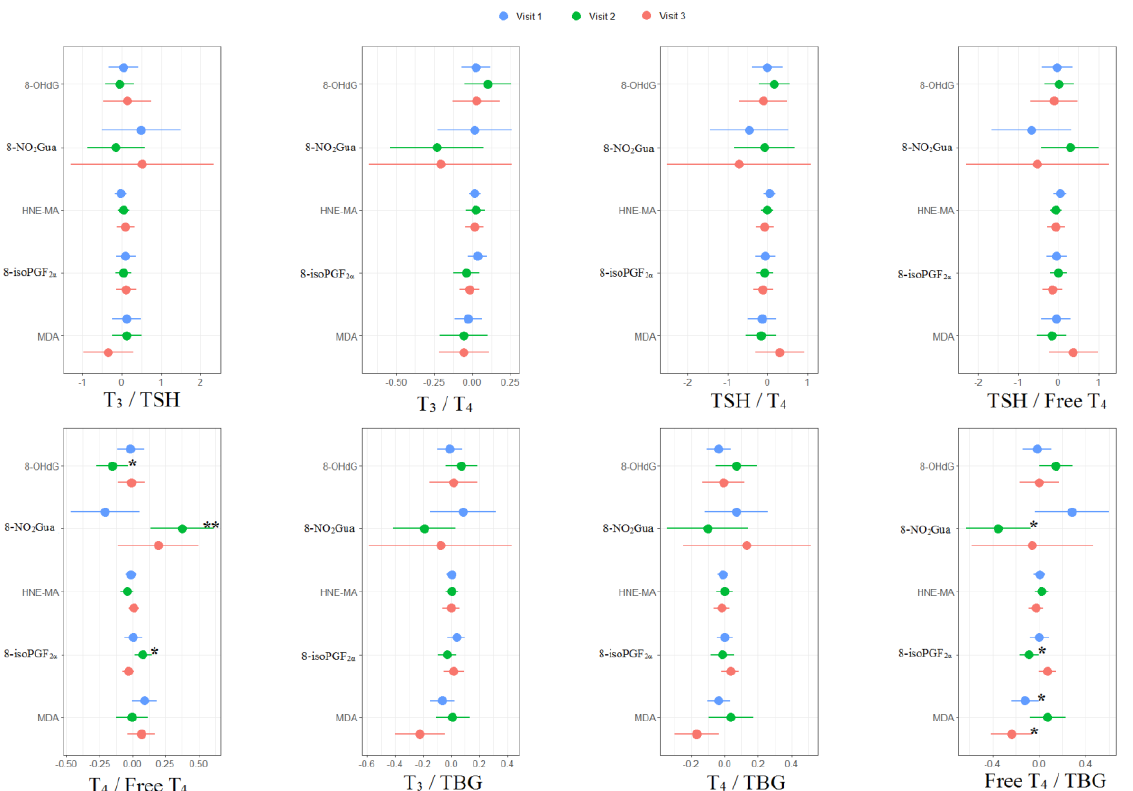
Figure 3. Unit change in oxidative/nitrosative stress biomarker concentrations in association with concentrations of thyroid hormone ratios across three visits. Multiple linear regressions are adjusted for age and creatinine; * p < 0.05, ** p < 0.01, *** p < 0.001.